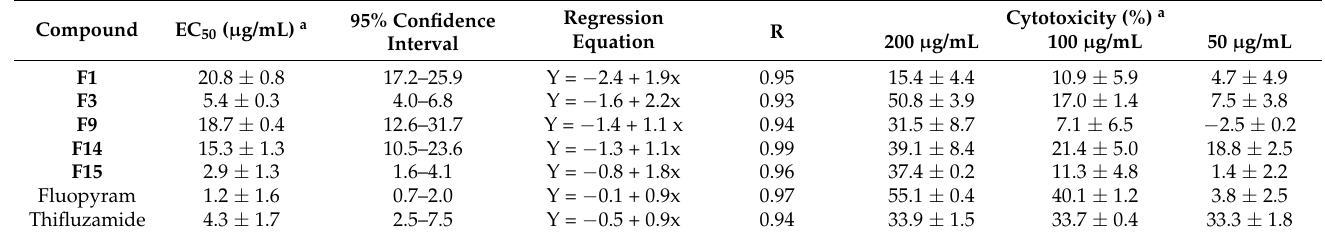
Table 2. The EC 50 values of partial compounds against S. scleotiorum and the cytotoxicity in normal cells